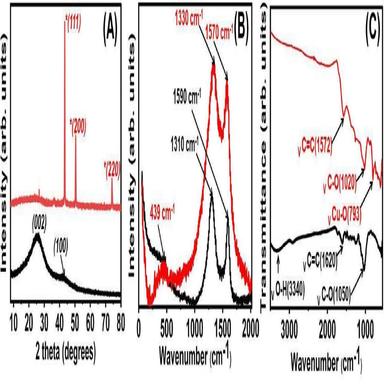
(A) PXRD patterns (B) Raman spectra and (C) FTIR spectra of ACC and Cu-ACC.